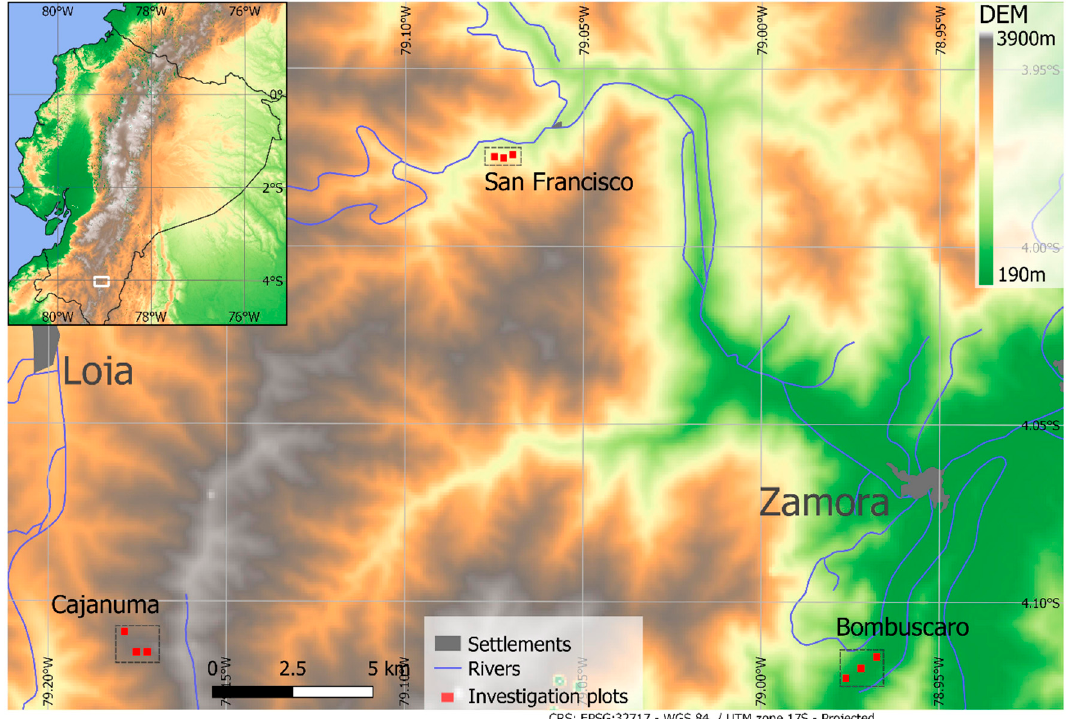
Figure 1. Plot locations at Bombuscaro (1000 m above sea level), San Francisco (2000 m above sea level.), and Cajanuma (3000 m above sea level). The DEM is based on SRTM data (USGS, 2006). The inlay shows the position of the research area in southern Ecuador.